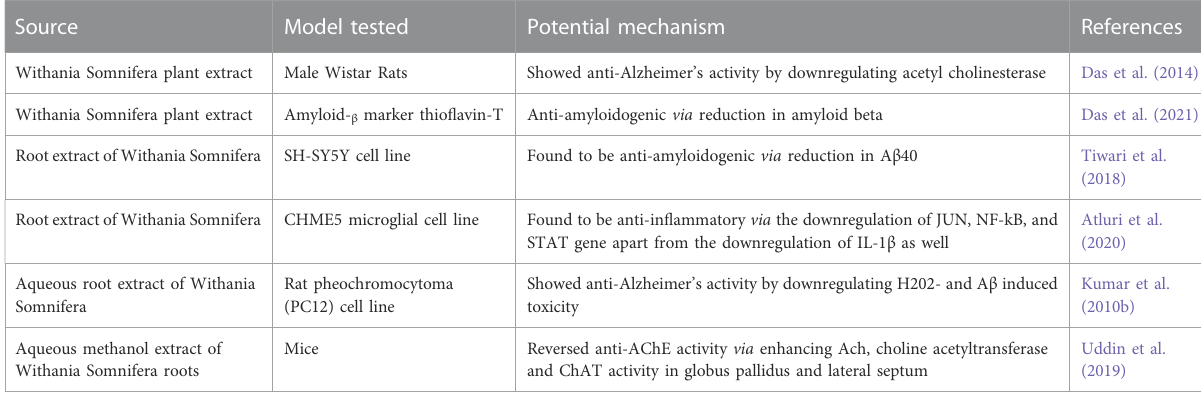
TABLE 2 Preclinical status of Withania Sominifera in neurodegenerative